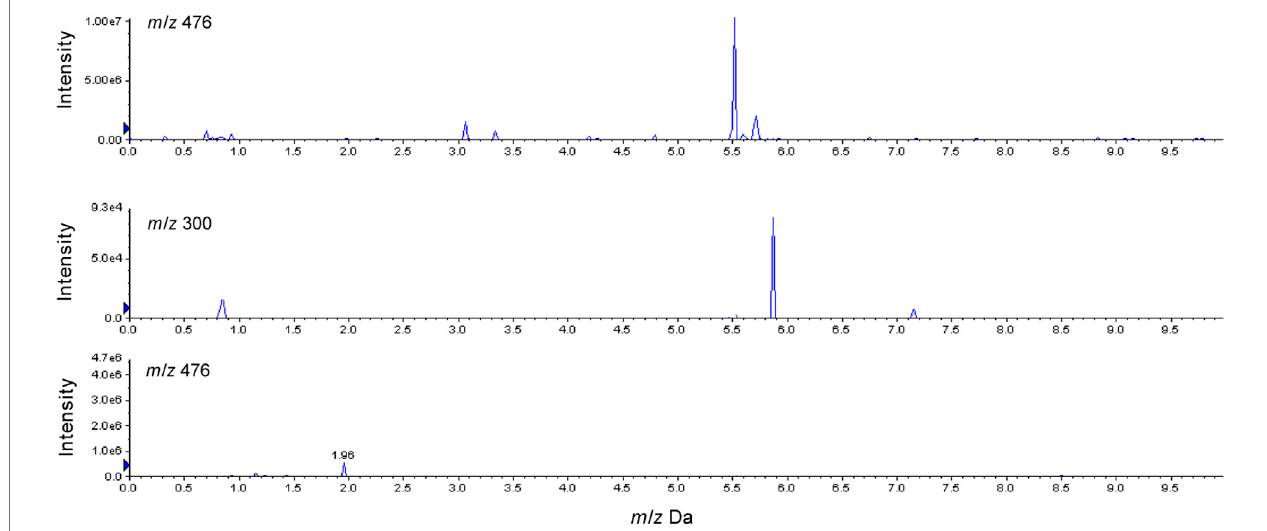
FIGURE 5 | Characterization of glucuronide conjugates in rats urine after oral administration of 2 before and after β -glucuronidase hydrolysis.